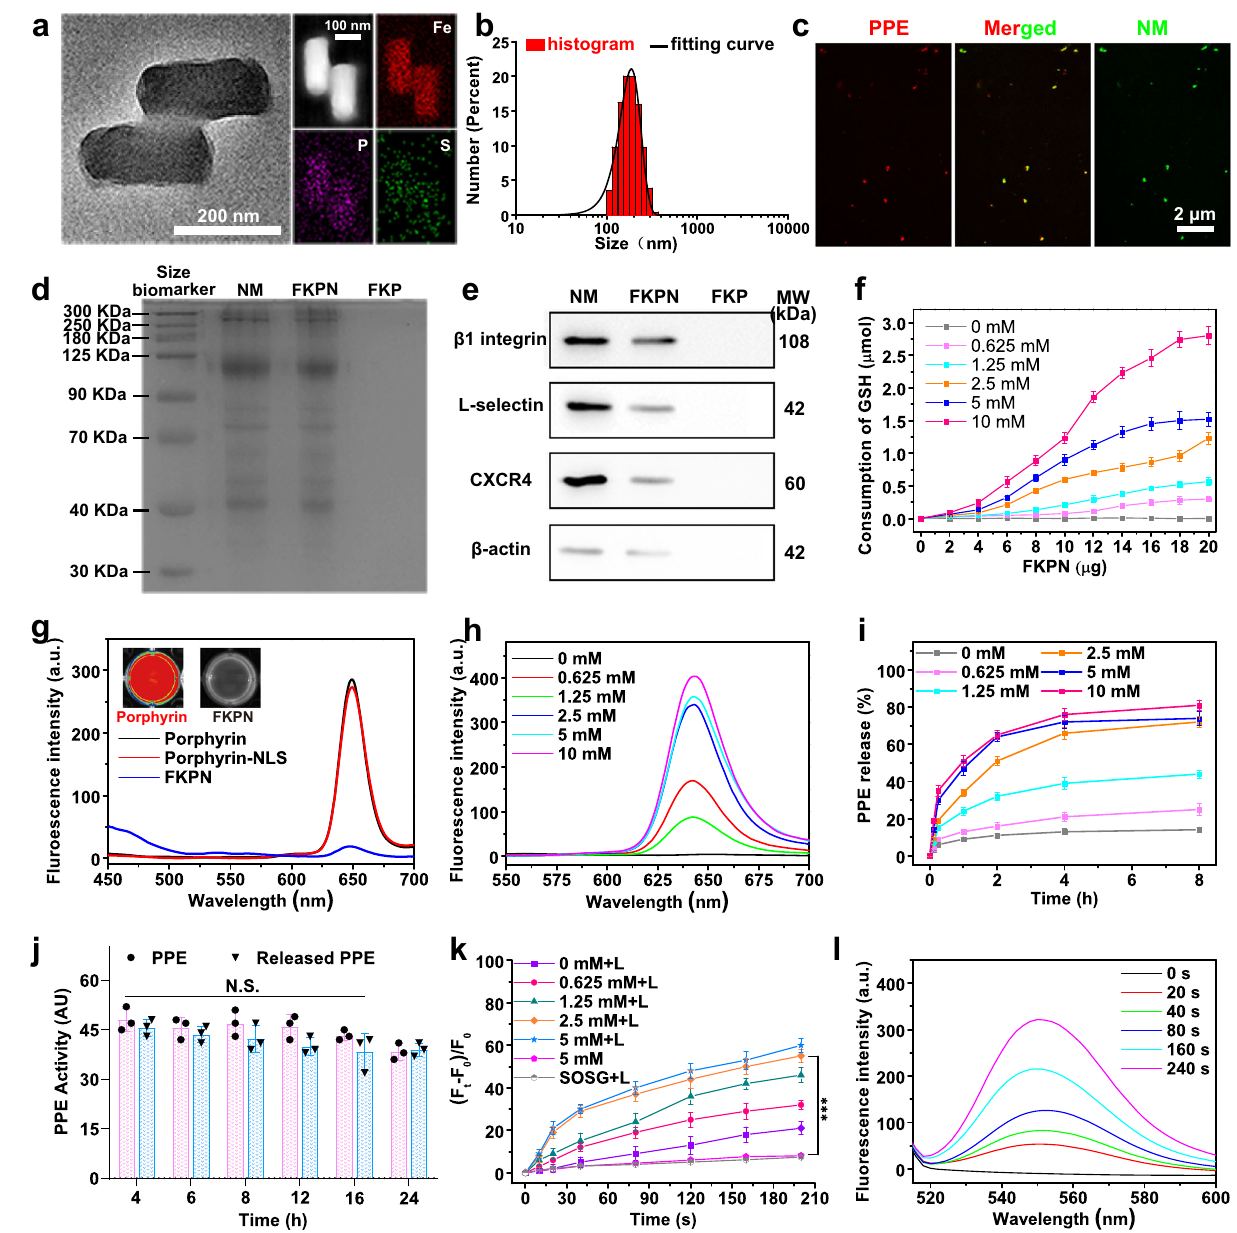
fl uorescent. h FKPN fl uorescence changes with different GSH